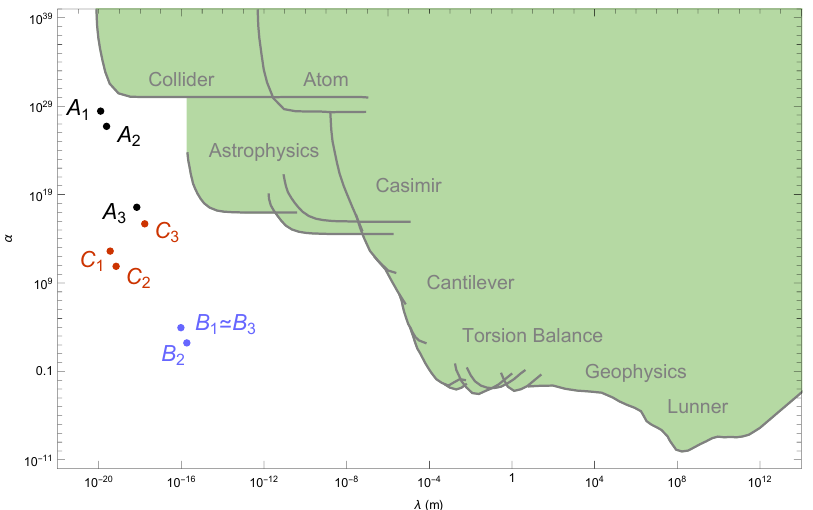
Figure 9 . A few examples of the corrections δV (4.18) to the Newtonian potential for different choices of the free parameters in (4.29). The hierarchy is fixed to H = 10 − 15 and g s = 0 . 2 in all parameter sets. All points A i have τ c = T = 40 , corresponding to the fully warped conifold limit. All points B i have τ c = 0 and T = 30 , corresponding to the unwarped conifold limit. All points C i have τ c = T/ 2 = 15 , corresponding to a mid-regime with a warped throat and a piece of the bulk described by an unwarped conifold. We also choose M = 20 and 75 for i = 1 , 3 and i = 2 , respectively, and τ b = 0 and 15 for i = 1 , 2 and i = 3 , respectively. We notice in particular that all predictions are outside the excluded region, with the couplings being too small to be probed at colliders and the length scales too small to be probed by large scale experiments. See main text for detailed discussion. Figure adapted from [23, 64], with the shaded area indicating the excluded region of parameter space at 95% confidence